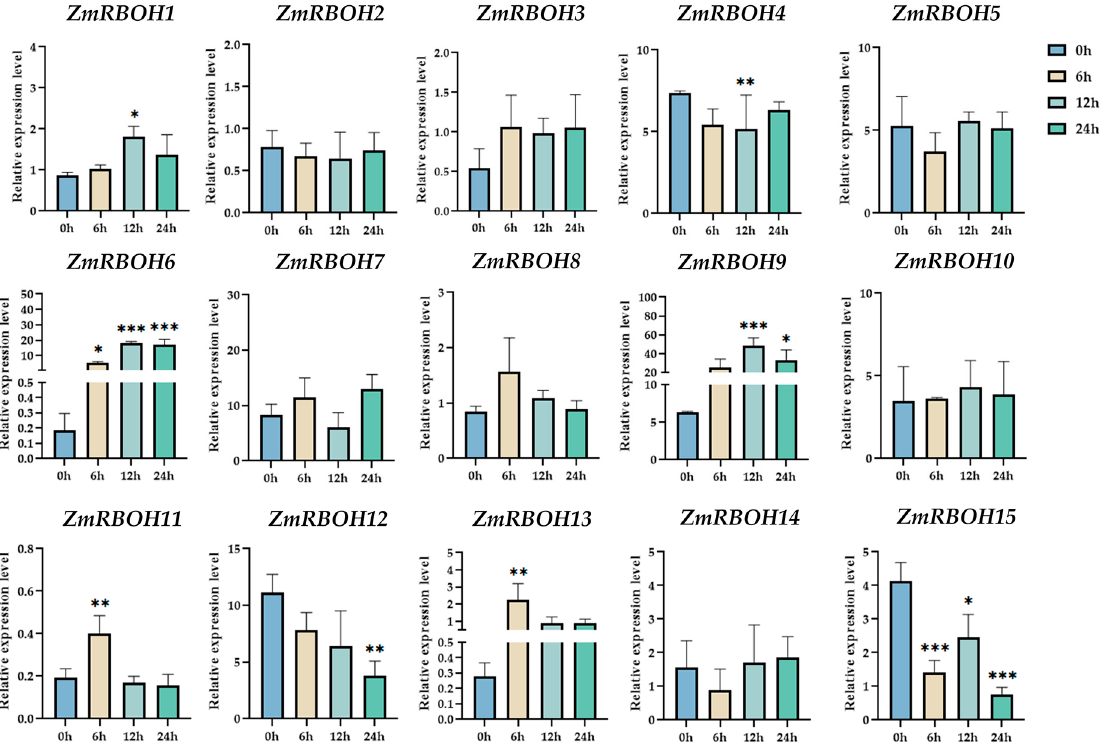
Figure 8. Quantitative RT-PCR analyses of ZmRBOH genes under cold stress. The results of quantitative RT-PCR were normalized to the ZmEF1 α and ZmActin housekeeping gene. The error bars indicate the standard deviations and the values in plots corresponding to the mean ± standard deviation (SD) of three independent biological replicates (* p < 0.05; ** p < 0.01; *** p < 0.001).